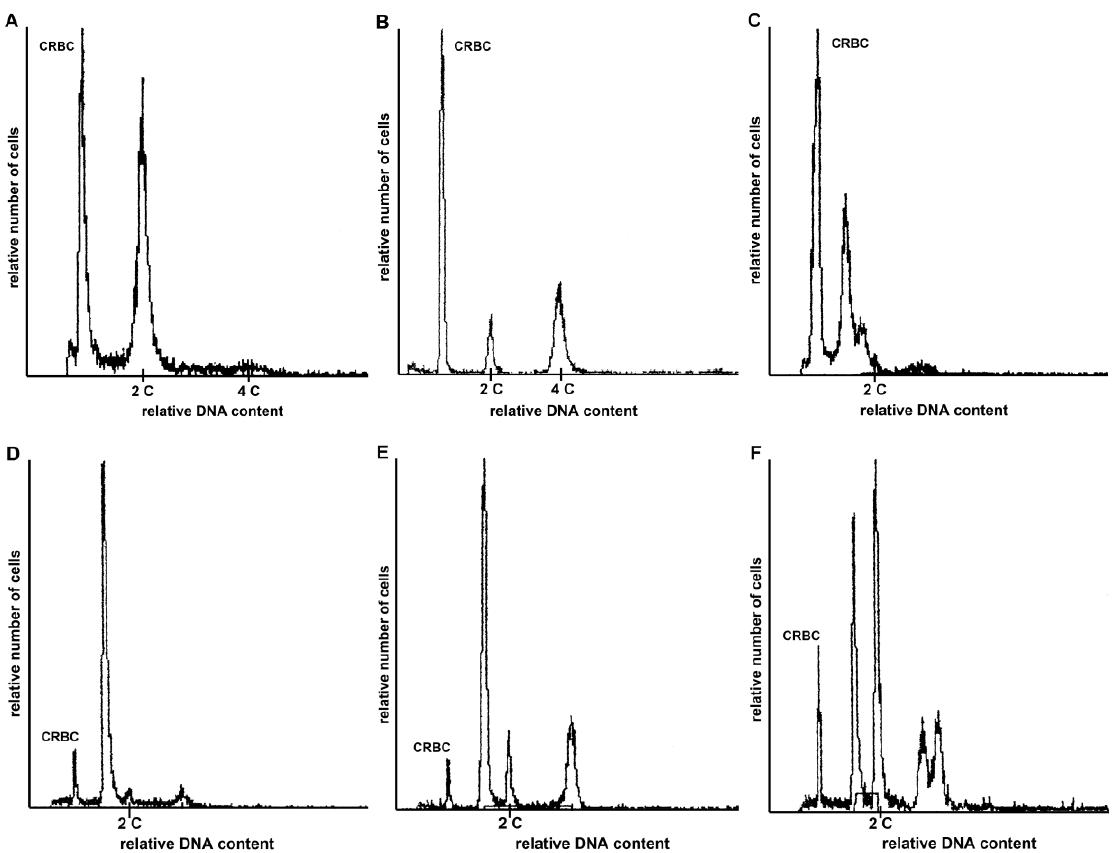
Figure 1. Example of DNA content histograms of canine